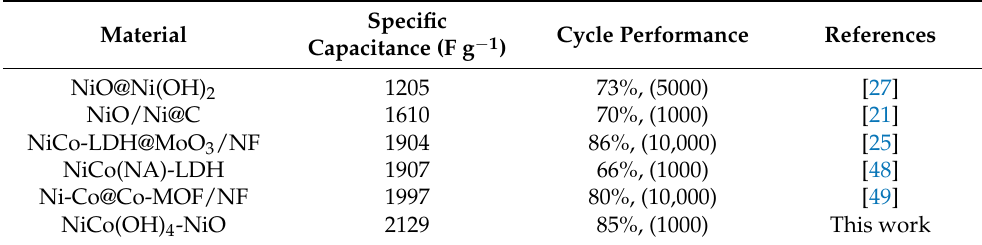
Table 1. The electrochemical performance between NiCo(OH) 4 -NiO and other electrode materials reported in previous